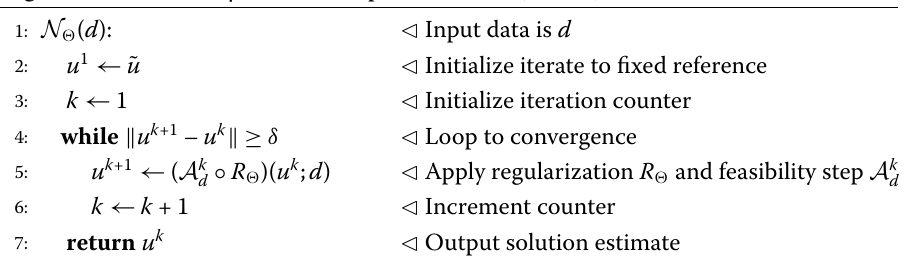
Algorithm 1 Feasibility-based fixed point network